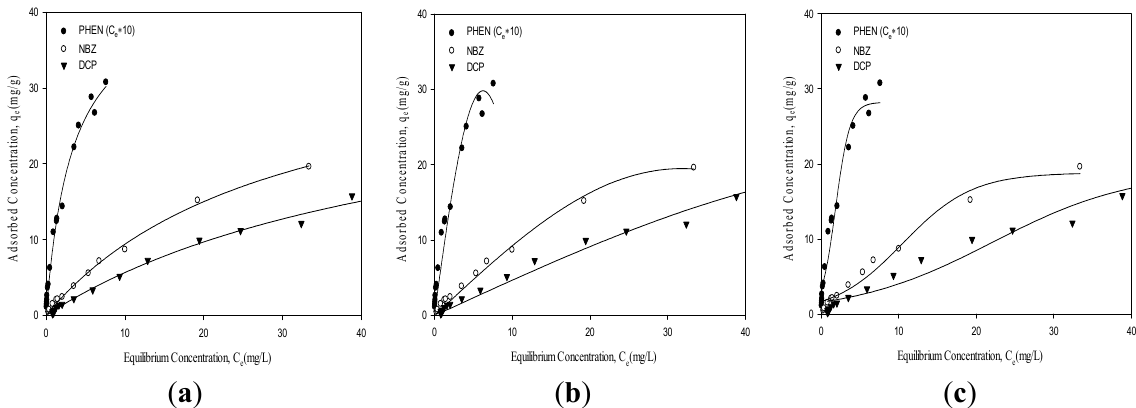
Figure 2. Fit to adsorption data of phenanthrene (PHEN), nitrobenzene (NBZ), and 2,4-Dichlorophenol (DCP) by the HBPMS using the ( a ) Freundlich (FM), ( b ) Sips and ( c ) Toth models.